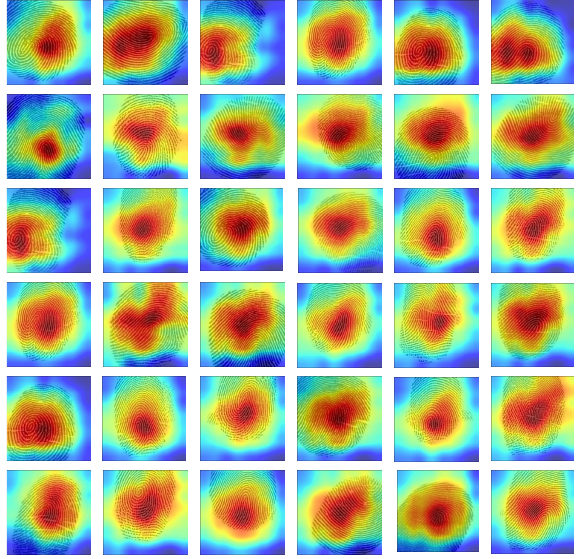
Figure 6. Overall